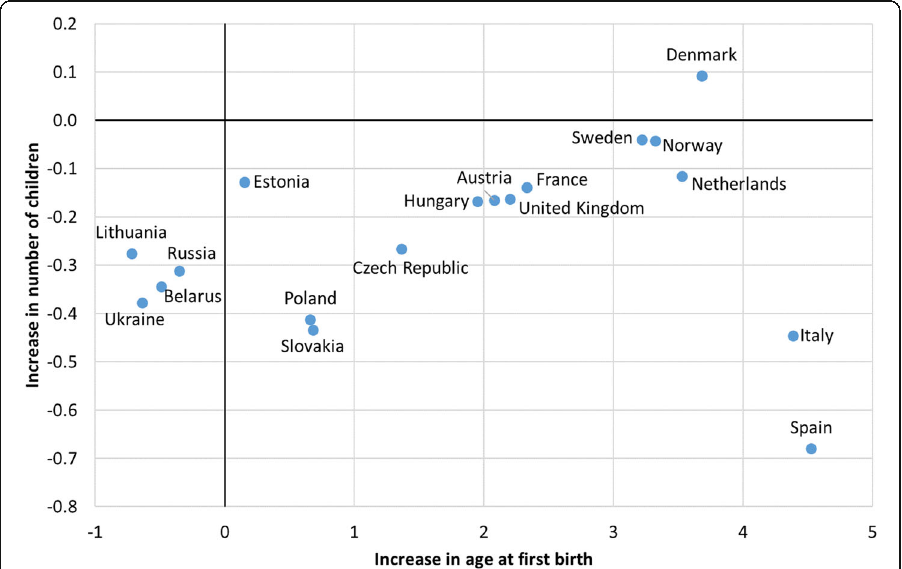
Fig. 6 Changes in the average maternal age at first birth and in the average number of children among cohorts of women born in 1952 and 1972, various European countries. Source: see Fig. 5. Variation in mean age at first birth (in years) is shown on the x -axis and variation in completed fertility (number of children per woman) on the y -axis. Variations are between the 1952 and 1972 birth